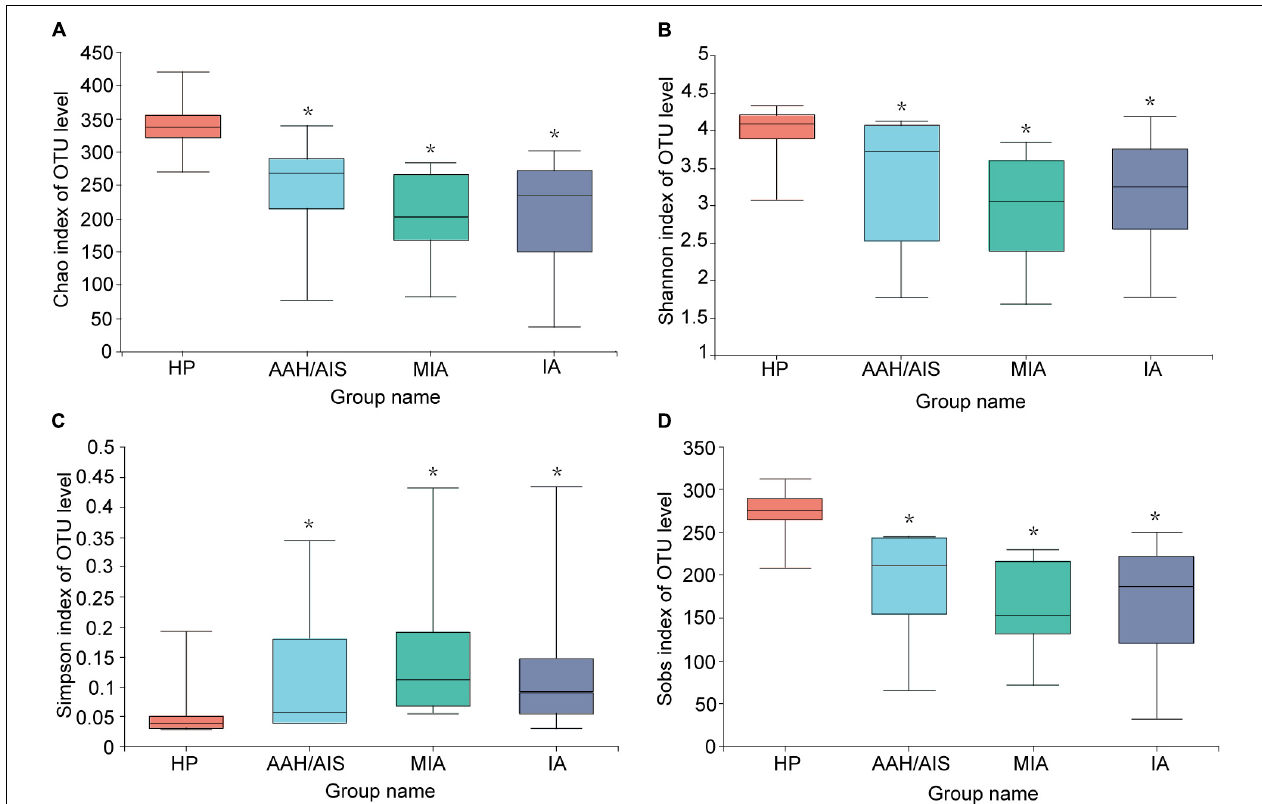
FIGURE 2 | Comparison of Alpha diversity index of intestinal flora among the four groups. (A) Microbial alpha diversity of Chao index. (B) Shannon index. (C) Simpson index. (D) Sobs index. *Indicates P < 0.05 compared to the HP